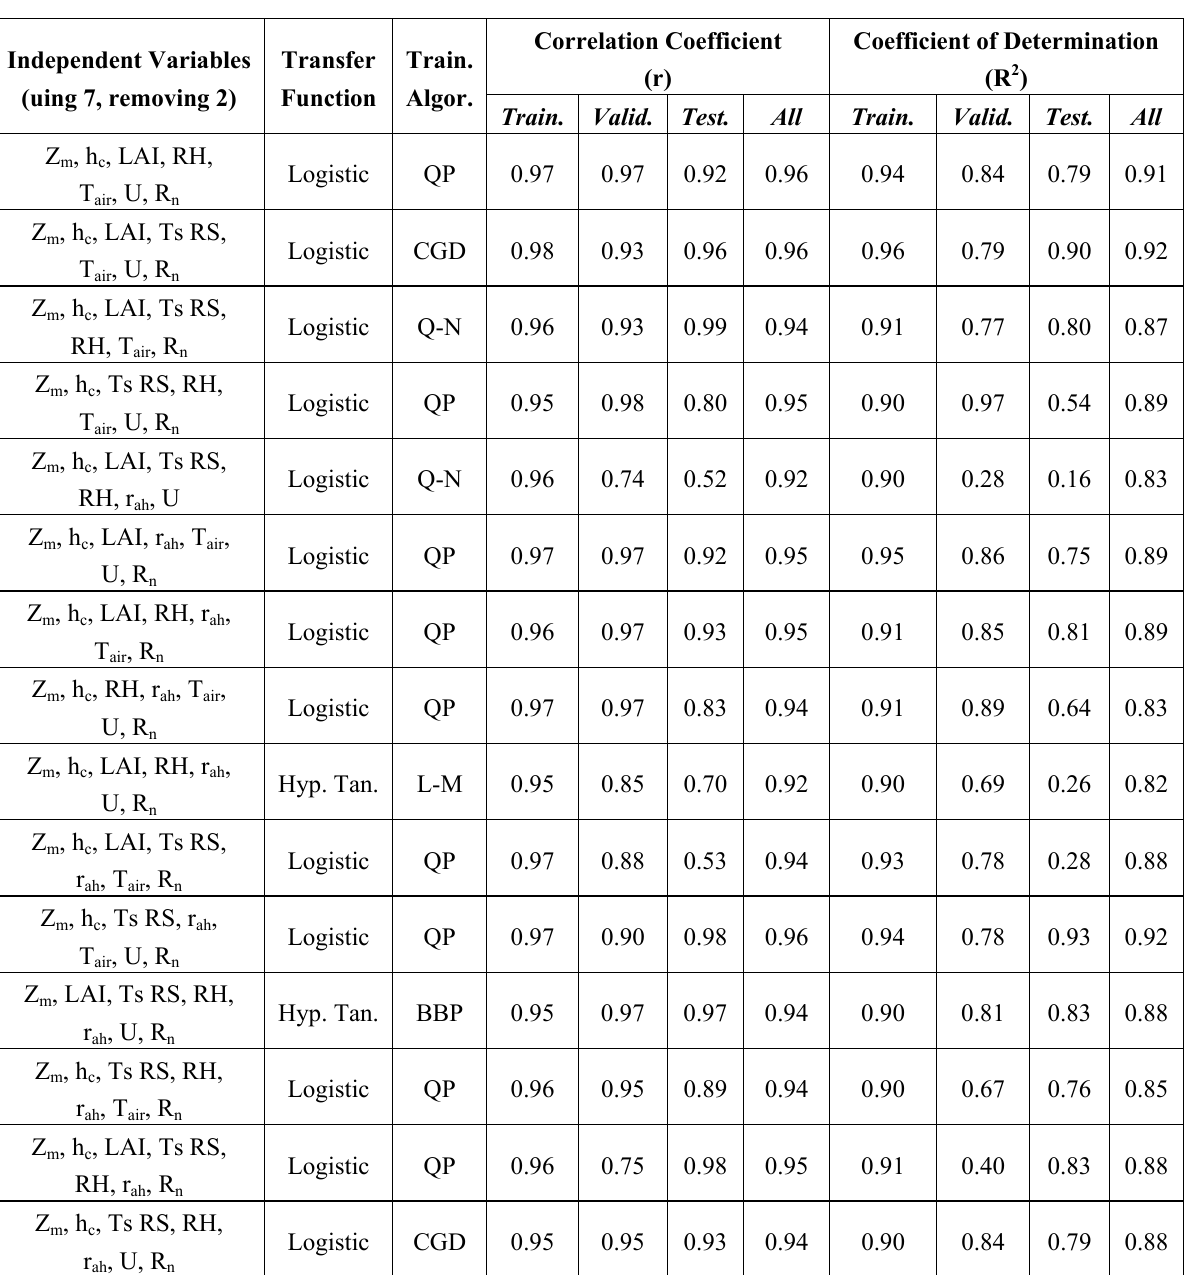
Independent Variables Transfer